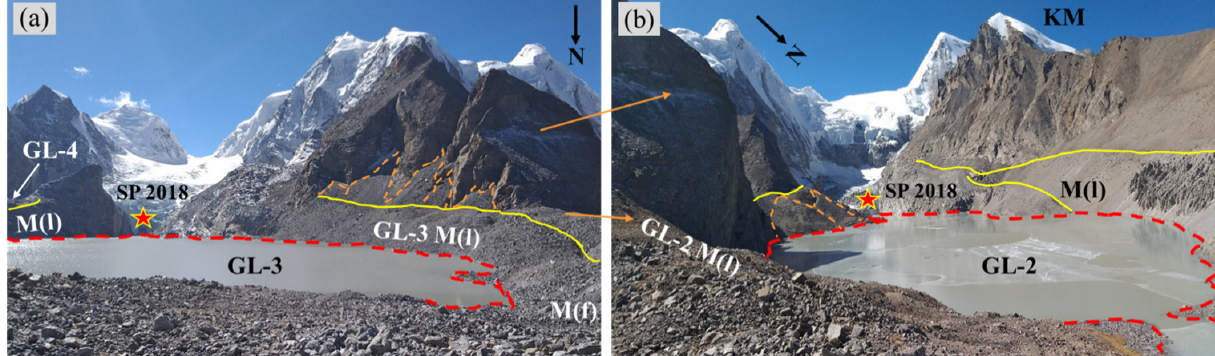
Figure 2. Geomorphological characteristics of proglacial moraine-dammed lakes sites: ( a ) GL-3; ( b ) GL-2. Note: red dashed lines (lake boundaries); yellow lines (moraine crest); orange break lines (unconsolidated debris-covered cone); SP, snout position; M(l), lateral moraine; M(f), frontal moraine; KM, Kangchengyao Massif. (Photo taken from the respective dam sites by Arindam Chowdhury in November 2018).